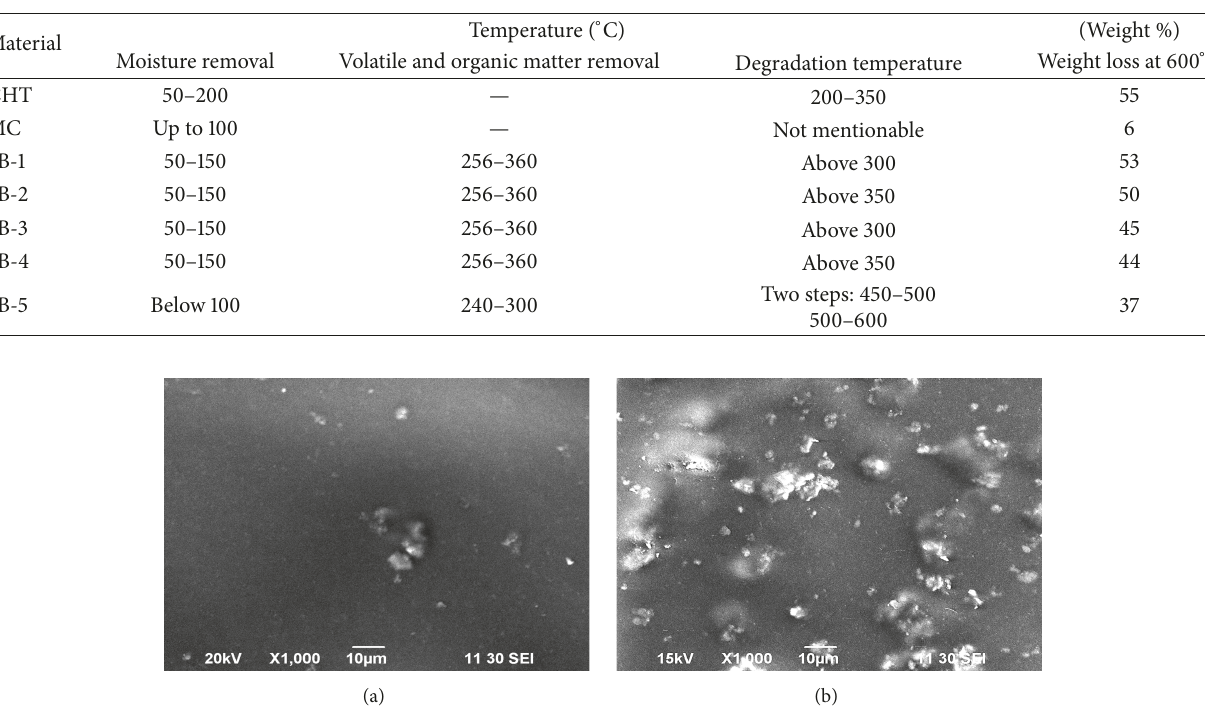
Table 4: Temperature profile and weight variation of the materials.